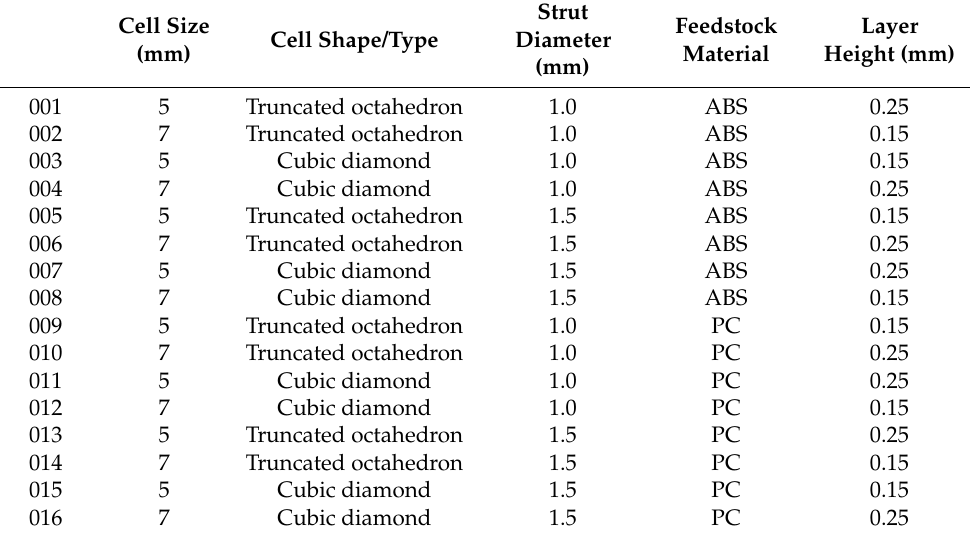
Table 3. Designation of each specimen and its characteristics.